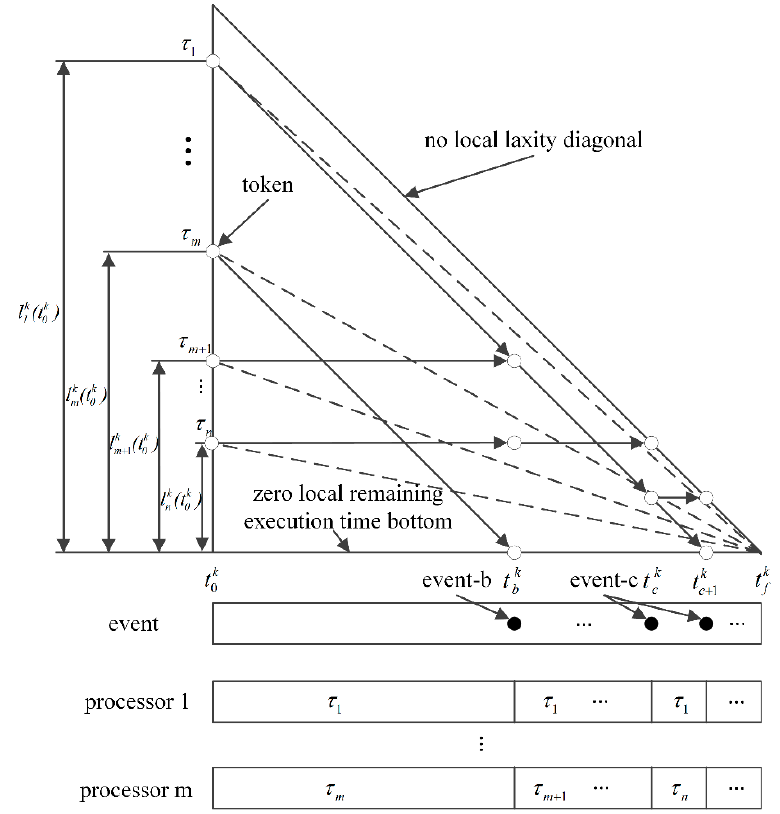
Figure 3. Scheduling in the k-th T-L plane.